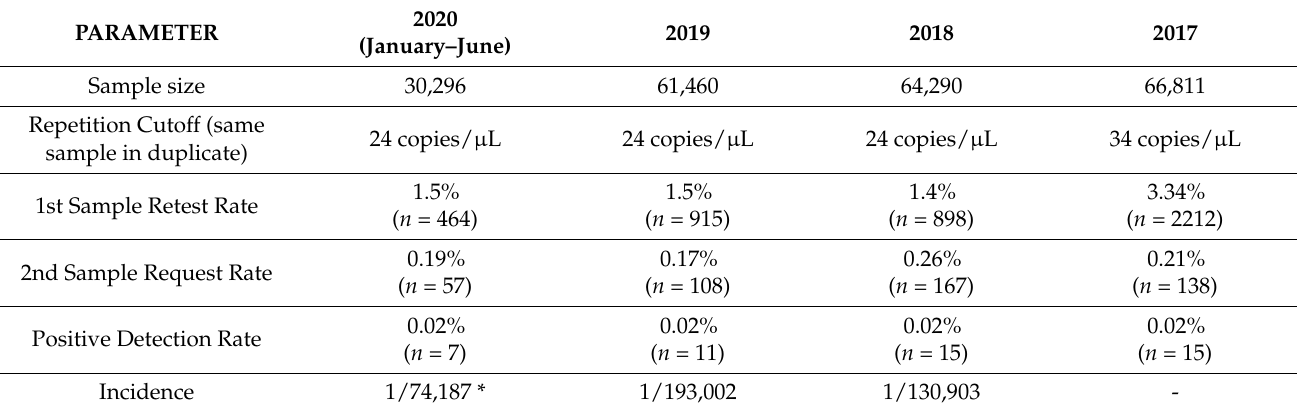
Table 2. Annual comparative data of NBS for SCID in